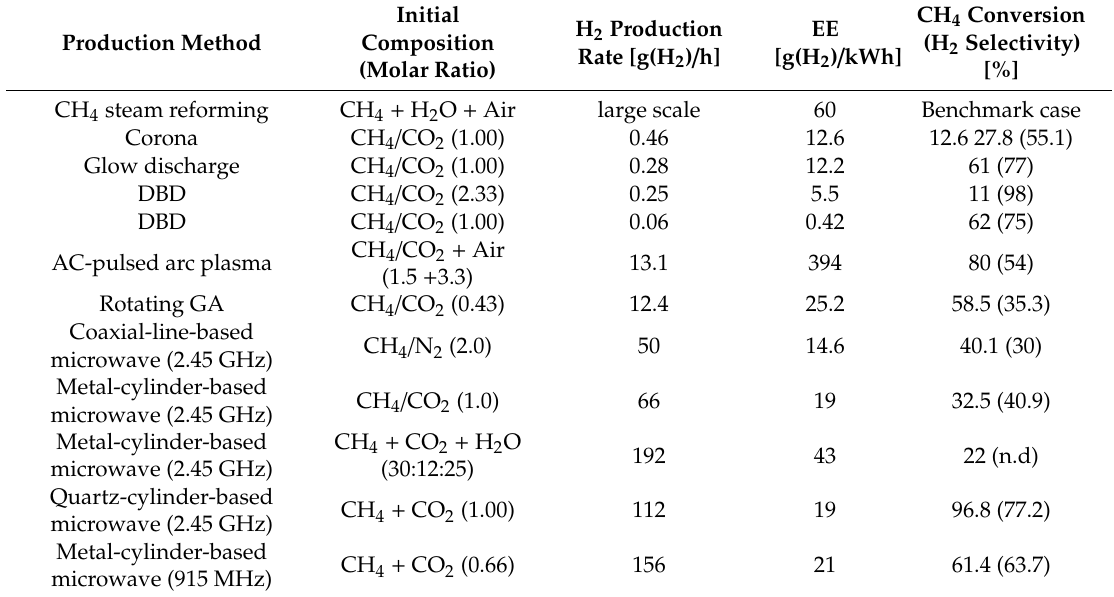
Table 4. Microwave plasma reactors employed of DRM